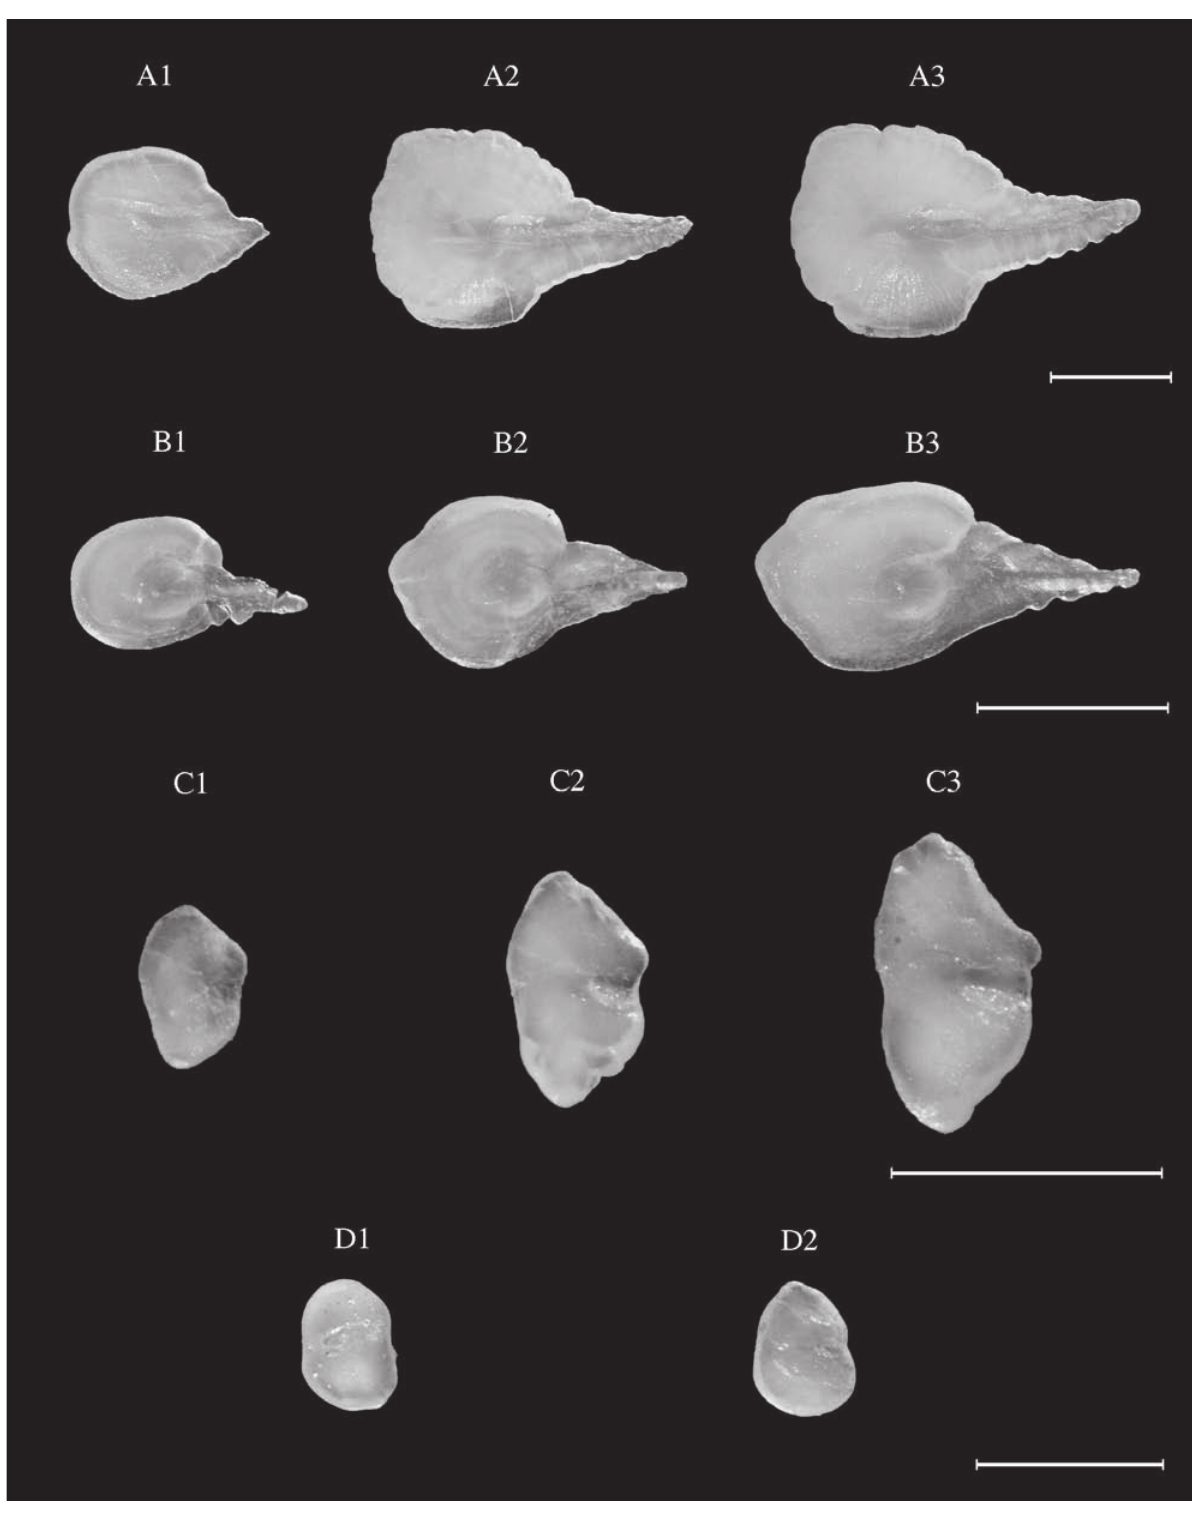
Fig. 18. – Gonostoma denudatum (NEA) . TL: A1, 7.4 cm; A2, 9.2 cm; A3, 10.0 cm. Gonostoma elongatum (NEA) . TL: B1, 10.2 cm; B2, 12.9 cm; B3, 15.7 cm. Argyropelecus aculeatus (NEA) . TL: C1, 3.5 cm; C2, 5.0 cm; C3, 6.9 cm. Argyropelecus hemigymnus. TL: D1, 3.8 cm (WM); D2, 3.9 cm (NEA). Scale bar = 1